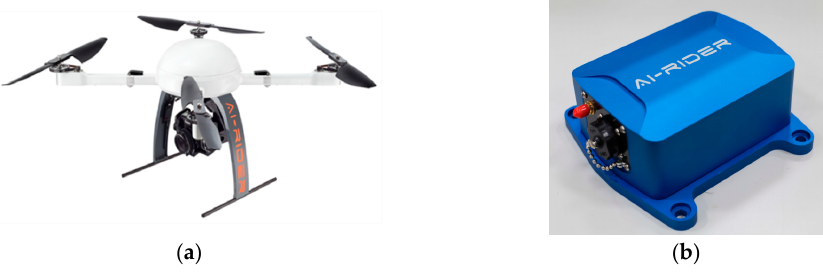
Figure 1. Quadcopter ( a ) Unmanned Aircraft Vehicle (UAV) and ( b ) inertial measurement units (IMU) used in this study. (Source: AI-RIDER Corp.)